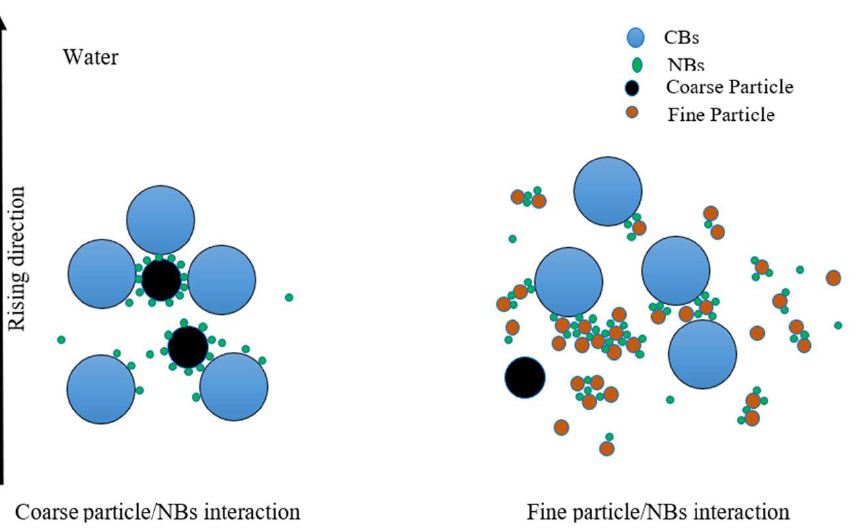
Figure 1. Representation of possible mechanism for coarse ( left ) and fine ( right ) particles floating in the presence of CBs and NBs.